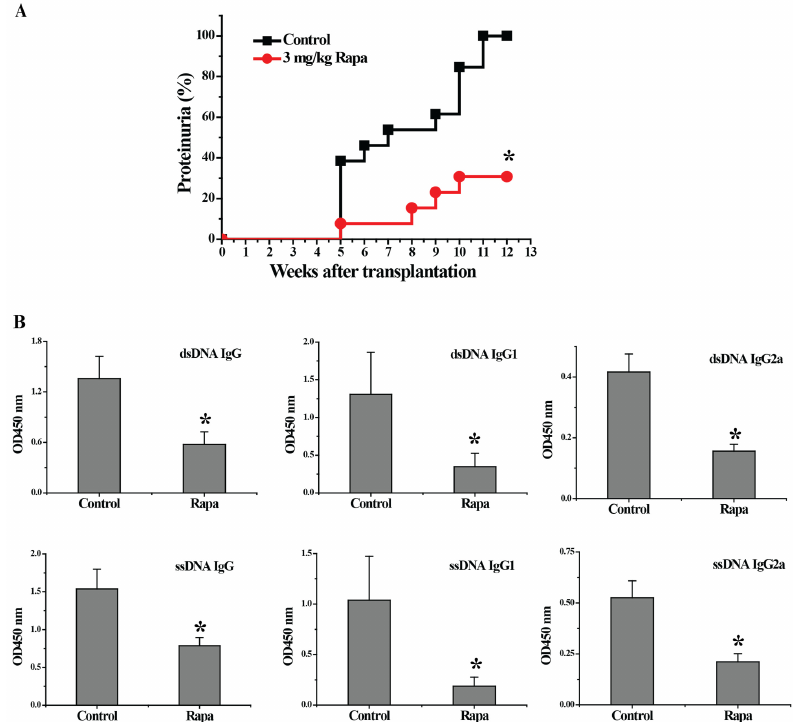
Figure 1. Rapamycin treatment delayed the onset of proteinuria and decreased serum autoantibodies levels in lupus ‐ nephritis ‐ bearing mice. ( A ) Urine was collected from week 1 to week 12 after transplantation. We found that 100% of the control group mice versus 30.77% of the rapamycin (Rapa) ‐ treated mice had developed proteinuria at the end of the experiments (n=13 per group). ( B ) Anti ‐ dsDNA and anti ‐ ssDNA autoantibody levels (total IgG, IgG1 and IgG2a) in blood serum col ‐ lected 3 weeks after transplantation were determined by ELISA ( n = 6). * p < 0.05. All these data suggest that rapamycin treatment ameliorated lupus nephritis in mice.